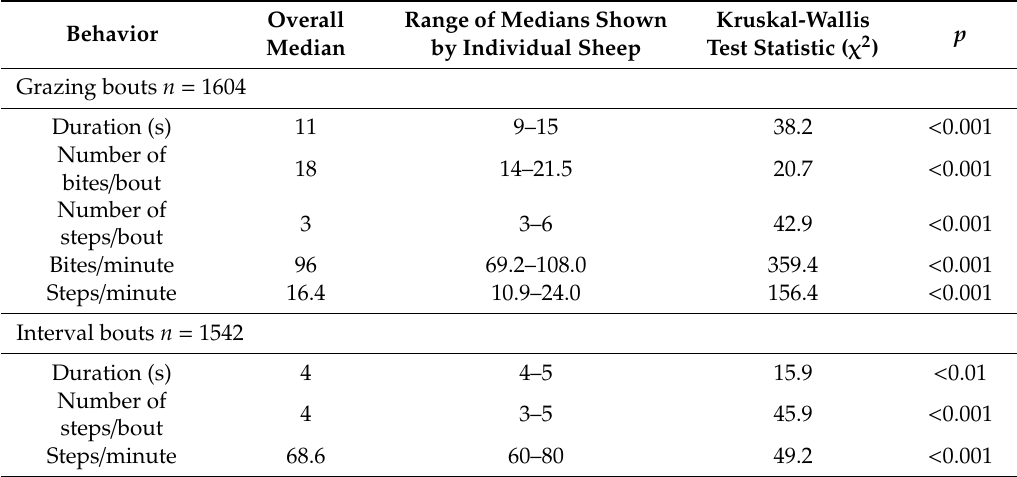
Table 1. Grazing and non-grazing (interval) bouts. All variables were found to be significantly non-normal (Shapiro–Wilks test); between-sheep comparisons were by the Kruskal-Wallis test.